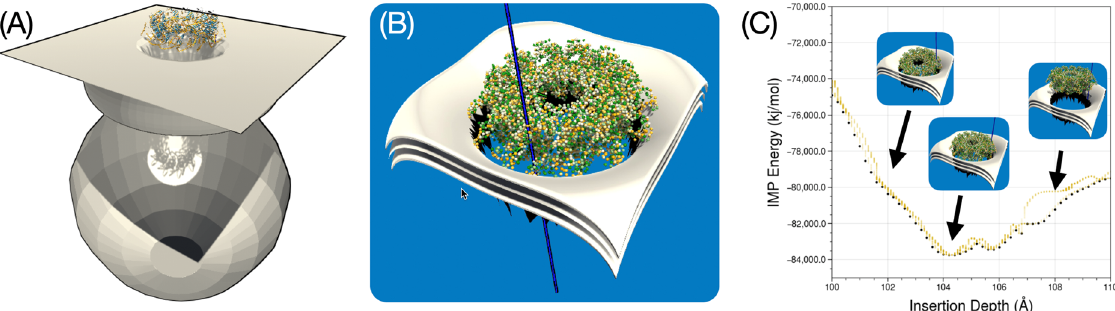
Figure 13. Experiments with curved membrane shapes to insert a dodecameric protein ring into such a bent membrane structure. ( A ) represents a thought model of the complex membrane shape to which the ring could be anchored. ( B ) is a close-range mesh we designed to test insertion into this membrane patch of arbitrary shape. The membrane midplane and head group regions are shown as layered sheets. ( C ) provides an overview of the insertion experiment and shows exploration of the insertion depth and three snapshots along the pathway. The approach to the protein ring is from the right side, representing the farthest distance, to a stable position (centre), and then to an exaggerated insertion (left) to illustrate how energy increases again in this last regime.